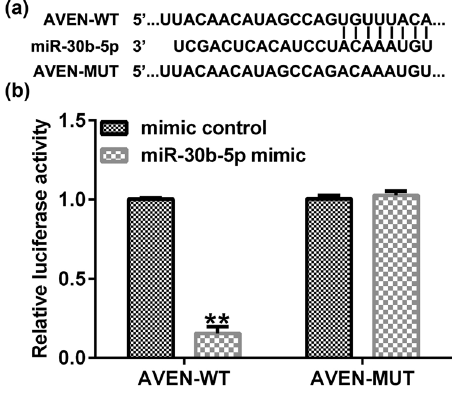
Figure 2: miR - 30b - 5p directly targets AVEN. ( a ) The potential binding site between miR - 30b - 5p and AVEN was predicted by TargetScan website. ( b ) The dual - luciferase gene reporter assay was completed to con fi rm the direct binding relationship between miR - 30b - 5p and AVEN. Data are represented as the mean value ± SD of three inde - pendent experiments. ** P < 0.01 vs Mimic control